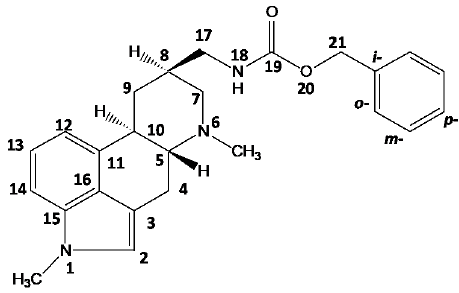
Figure 1. Chemical structure and numbering of metergoline, C 25 H 29 N 3 O 2 .